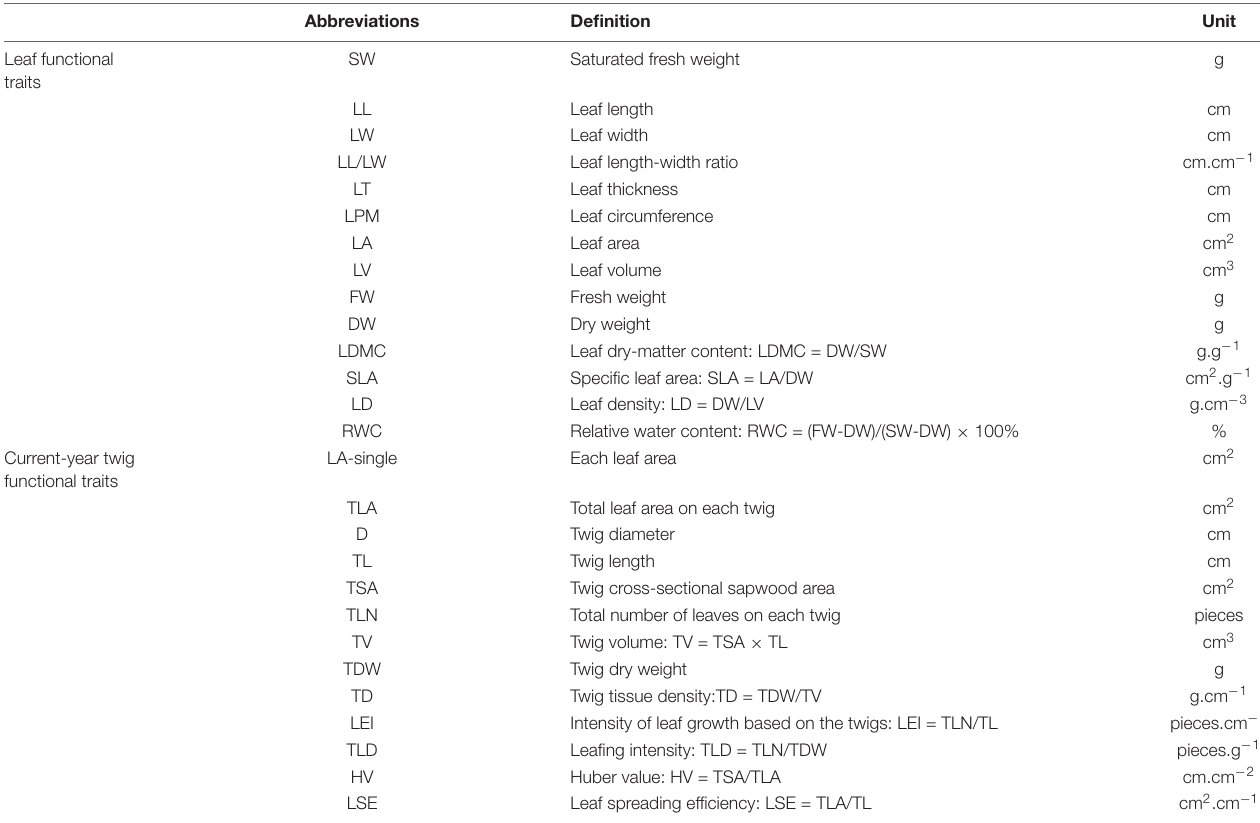
TABLE 2 | The abbreviations of functional traits of leaf and current-year